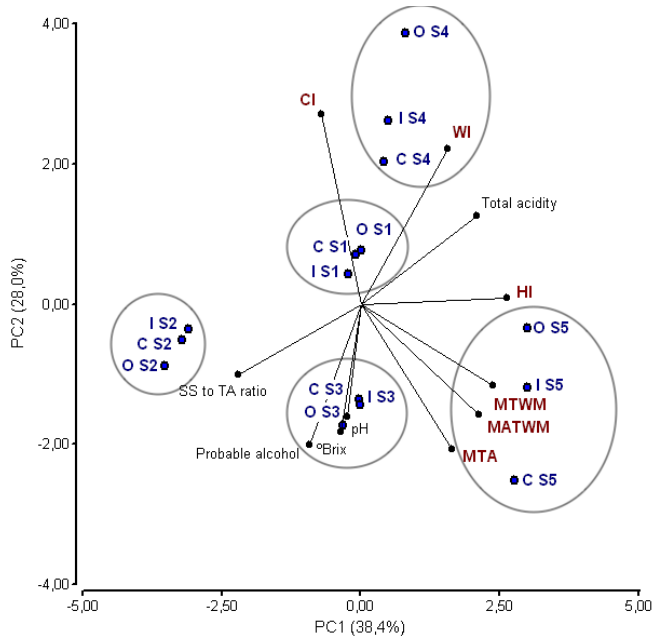
Figure 2. Principal component analysis (PCA) performed with berry composition from a Cabernet Sauvignon vineyard planted in an organic (O), integrated (I), and conventional (C) managements, together with different bioclimatic indices such as cool night index (CI), Huglin’s Heliothermal Index (HI), mean thermal amplitude (MTA), Winkler Index (WI), average mean temperature of the warmest month (MTWM), and maximum average temperature of the warmest month (MATWM) along five consecutive seasons (S).